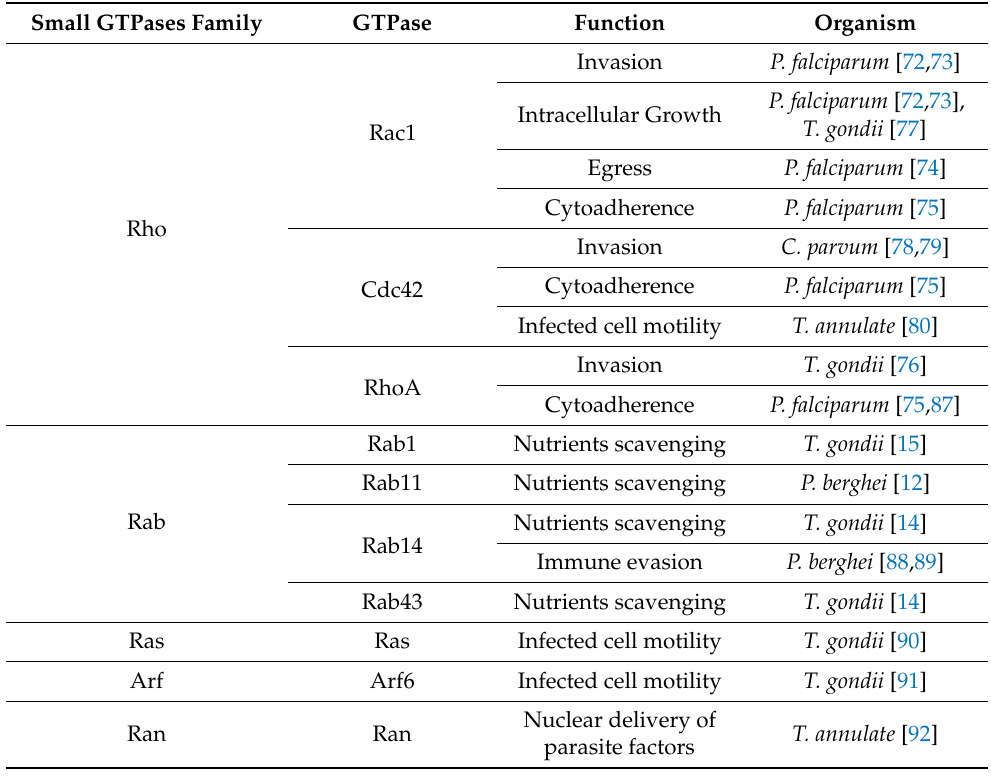
Table 1. Summary table of the host small GTPases exploited by apicomplexan parasites. Small GTPases